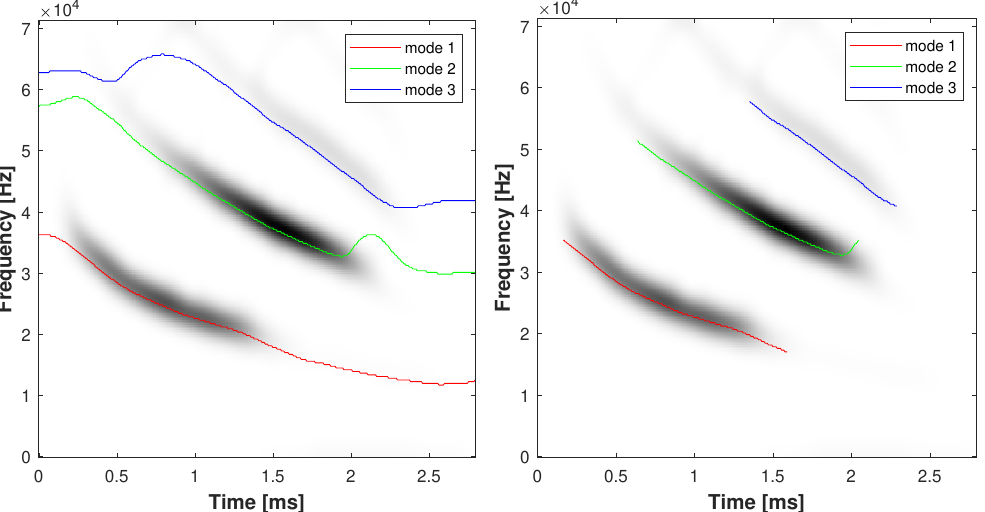
Figure 12. Estimation of K = 3 signal components of the bat record signal by using the proposed ABD method with α = 0.4, β = 0.7 with ( right ) and without ( left ) performing the